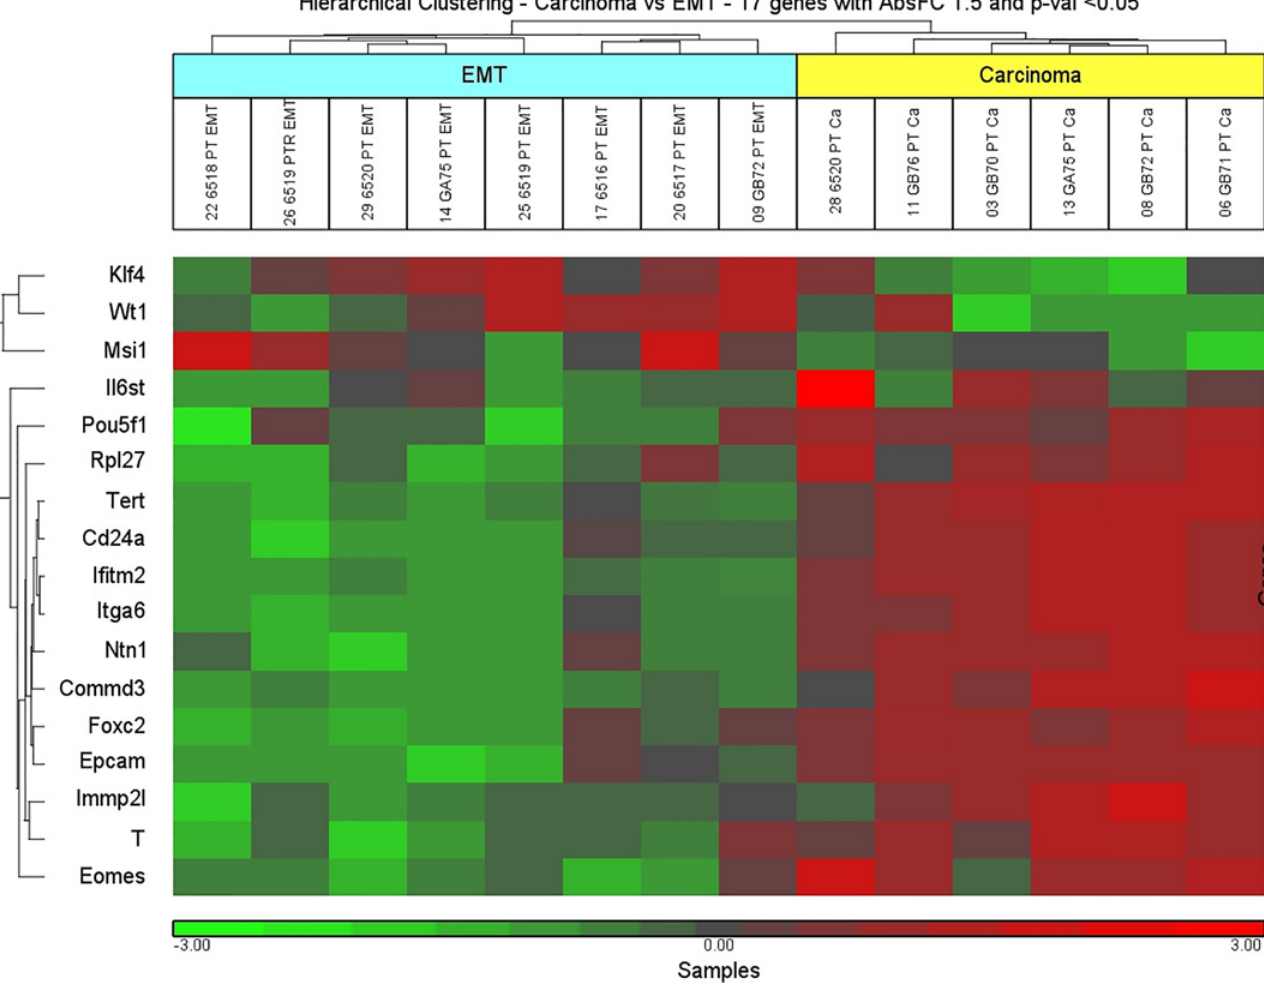
Fig 5. Unsupervised hierarchical clustering of carcinoma versus EMT. Scaled down representation of the entire cluster is based on 17 genes differentially expressed between carcinoma (epithelial-like areas) and EMT (spindle-like areas). Each row represents a single gene and each column represents a sample. Red color indicates upregulation, green color — downregulation, and black color — no change in expression level compared with the reference sample. EMT: Epithelial-Mesenchymal